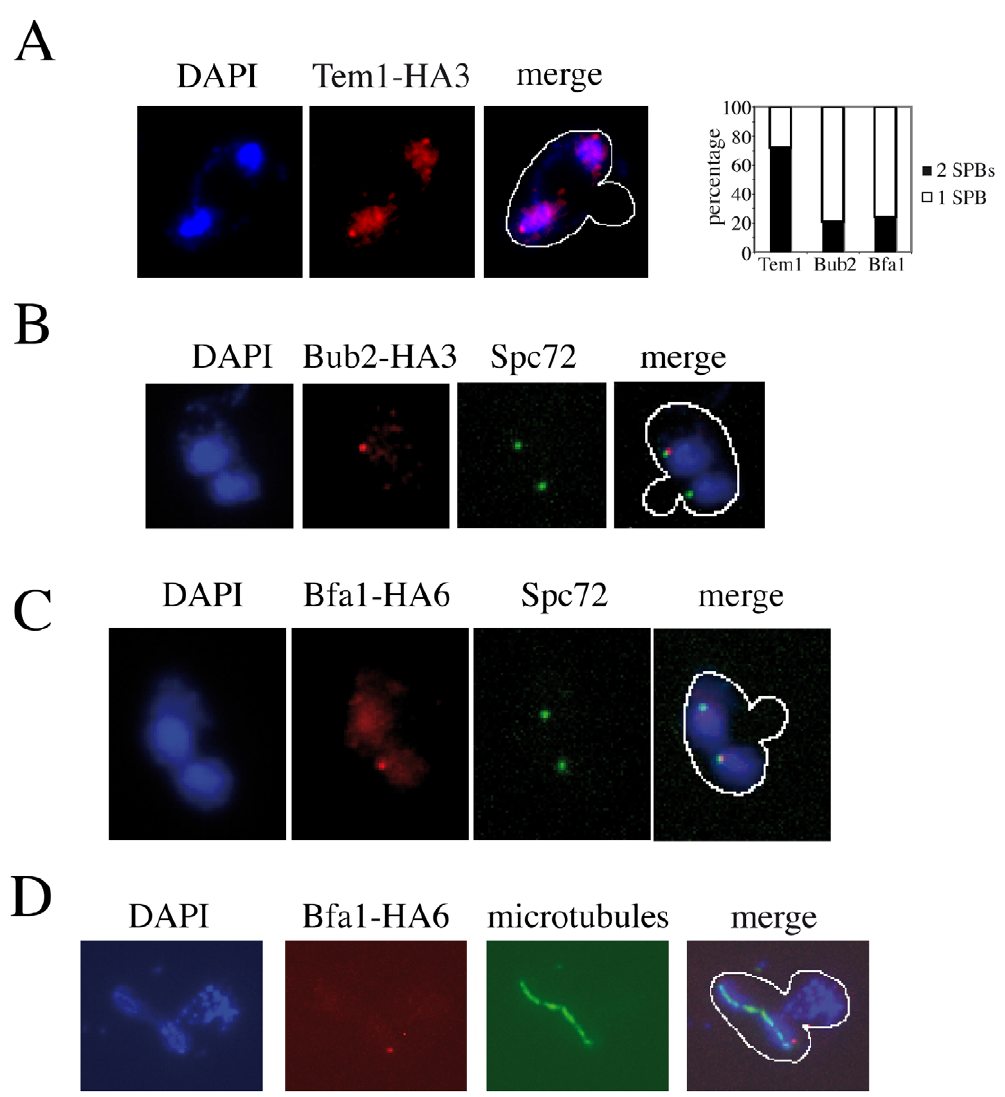
Figure 5. Asymmetric SPB localization of Bub2/Bfa1 in dma1 D dma2 D cla4-75swe1 D cells with mispositioned spindle. A–C: Cells were grown in YEPD at 25 u C and shifted to 37 u C for 3 hours, followed by nuclear staining with DAPI and visualization of the indicated proteins and of the SPB component Spc72 by indirect immunofluorescence. Only micrographs of cells with mispositioned spindles are shown. A: dma1 D dma2 D cla4-75 swe1 D cells (ySP7789) expressing HA-tagged Tem1 (Tem1-HA3). B: dma1 D dma2 D cla4-75 swe1 D cells (ySP7771) expressing HA-tagged Bub2 (Bub2- HA3). C: dma1 D dma2 D cla4-75 swe1 D cells (ySP7819) expressing HA-tagged Bfa1 (Bfa1-HA6). D: dma1 D dma2 D cla4-75 swe1 D cells (ySP7819) expressing Bfa1-HA6 were grown in synthetic medium lacking uracil at 25 u C, synchronized in G1 by alpha factor and released at 37 u C, followed by nuclear staining with DAPI and visualization of Bfa1-HA6 and microtubules by indirect immunofluorescence. Micrographs were taken 90 minutes after release, when the percentage of mispositioned anaphase spindles was maximal.